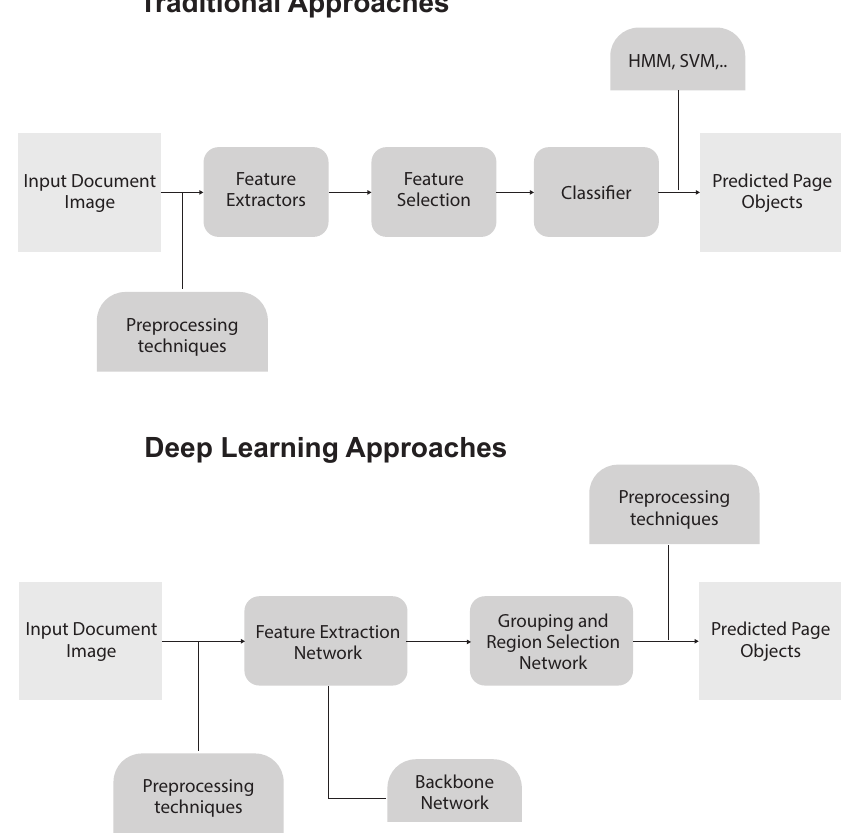
Figure 4. Visual depiction of the basic differences between the traditional methods and the deep learning-based techniques. Traditional approaches rely heavily on image processing methods and custom heuristics whereas deep learning techniques leverage convolutional neural networks-based architectures. In deep learning approaches, spatial features from the document images are extracted from backbone networks such as VGG-16 [14] or ResNet [15]. These features are further propagated to region detection or segmentation networks to classify and localize page